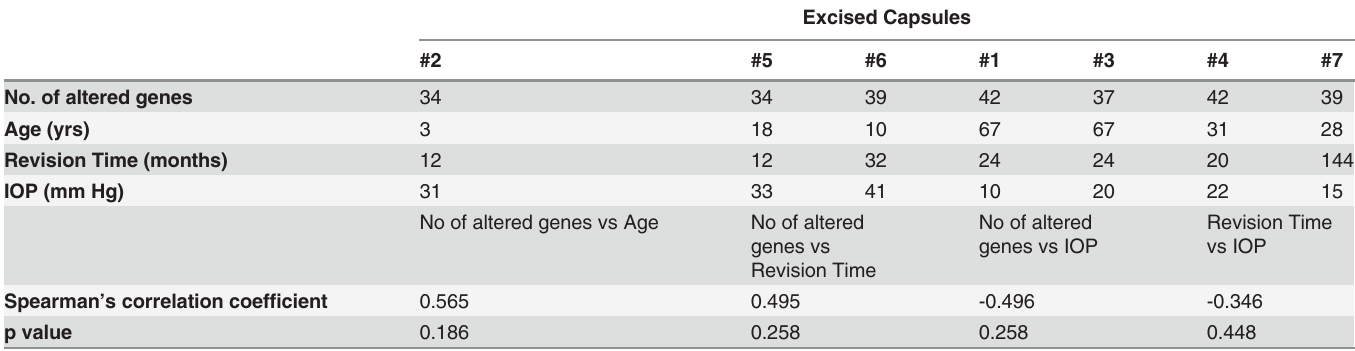
Table 3. Correlation of number of altered genes ( (cid:1) 2 fold) in fibrosis array with age, time to revision and